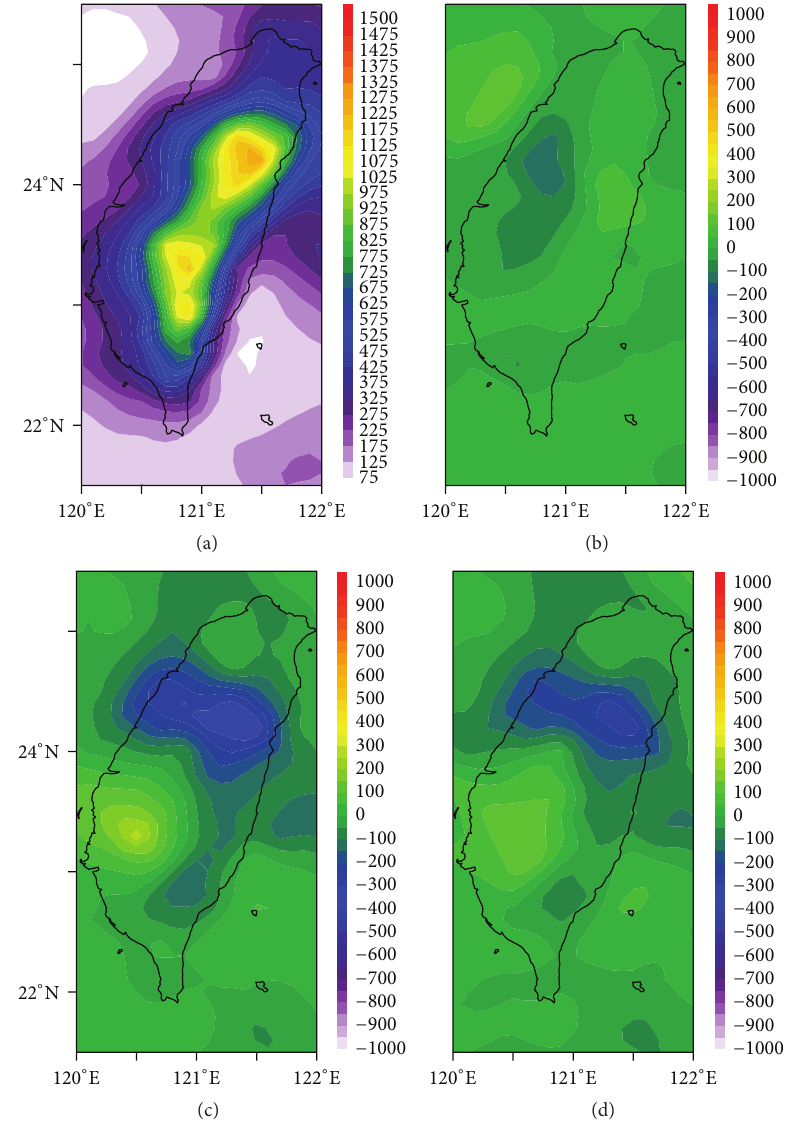
Figure 9: (a) Horizontal maps of the 54 h accumulated rainfall (units: mm) over Taiwan from CTRL experiment during 0000 UTC 17 July to 0600 UTC 19 July 2005; (b) differences of the 54h accumulated rainfall (units: mm) between No hflux and CTRL experiment; (c) and (d) are the same as (b) but for No qflux and No flux.